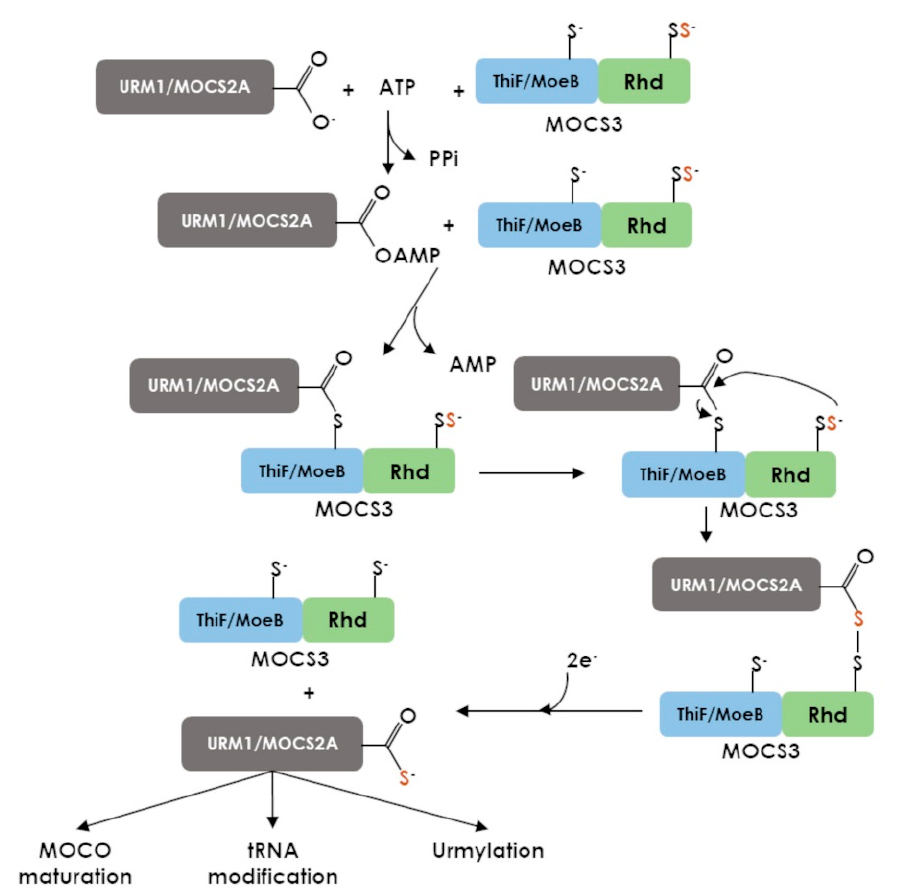
Figure 10. Proposed mechanism for the MOCS3-catalyzed reaction.